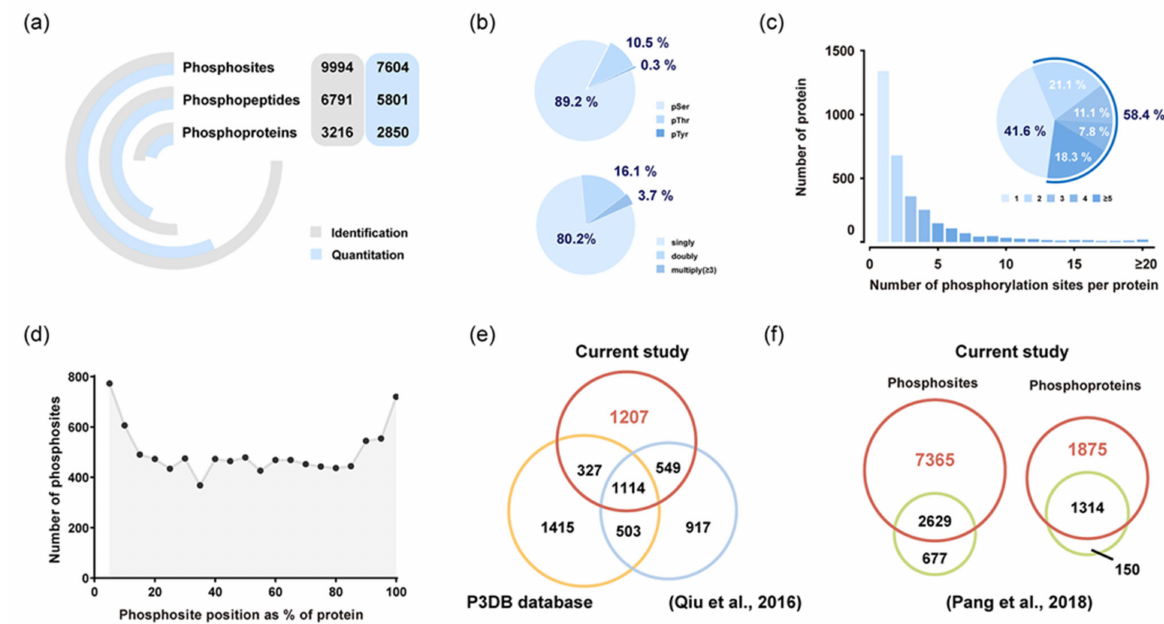
Figure 2. Characteristics of the phosphoproteome of rice endosperm at the critical grain-filling stage. ( a ) Summary of phosphoproteome analysis in rice endosperm. ( b ) Distribution of the number of phosphates and phospho-amino acid residues for all quantifiable phosphopeptides. ( c ) Frequency distribution of phosphoproteins according to the number of phosphosites identified. ( d ) Positional distribution of the identified phosphosites in protein sequences. ( e ) Overlap of the identified phosphoproteins in our study with phosphoproteins in the japonica datasets—the P3DB database [24] and